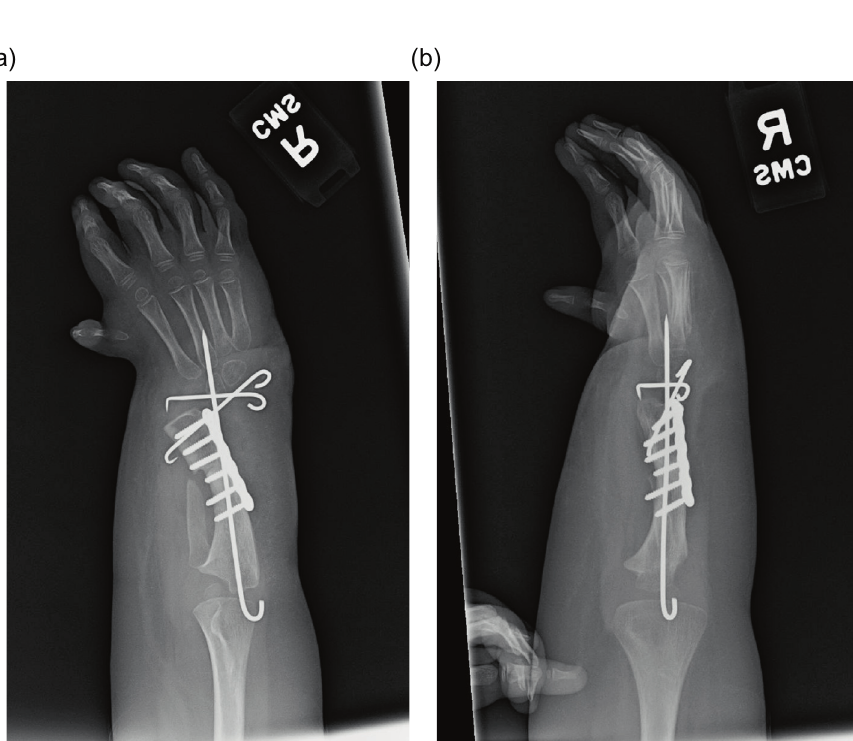
Figure 27. AP and lateral radiographs after ulnarization with shortening. Note the temporary arthrodesis wires in place and the plate on the